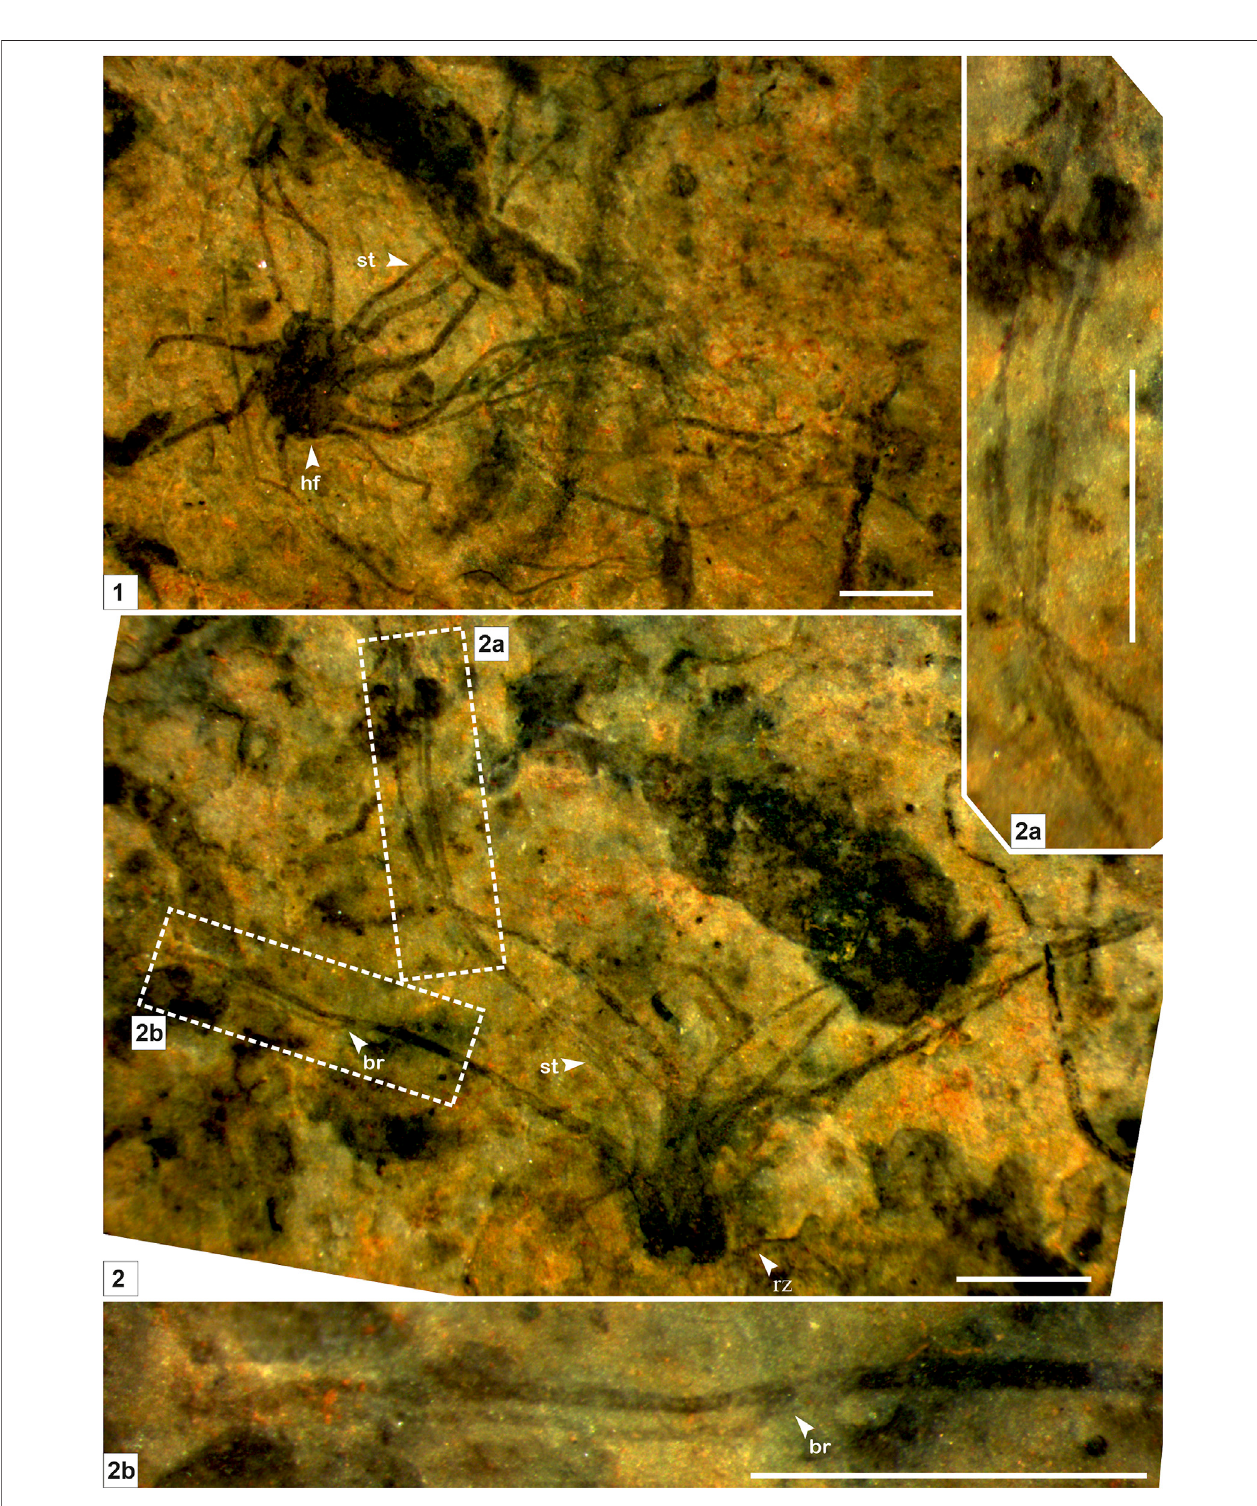
FIGURE 2 | Macroscopic fossil Palaeoscytosiphon shuklaii n. gen., n. sp. from the Saraipali Formation. (Arrow indicates the prominent features: st. stalk; br. branching; hf. holdfast; rz. rhizoid.) (1 – 2) . 1 . Type specimen comprised of compressed thallus with long multiple tubular stalks attached with a discoidal holdfast at the base; 2. Longitudinal preservation of Palaeoscytosiphon shuklaii ; 2.a, 2.b. Enlarged view of Panel 2 showing secondary branching in stalks. 1. Specimen no. BSIP 41897; 2. Specimen no. BSIP 42022. Scale bar is 2 mm for each specimen.